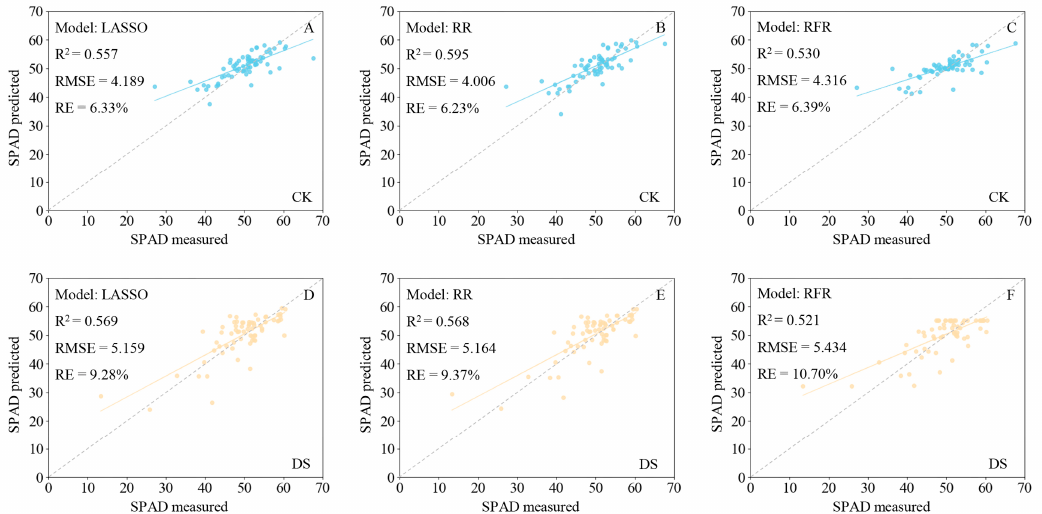
Figure 7. Fitting results of predicted and measured SPAD values of wheat leaves based on a full- band hyperspectral reflectance model under different soil moisture conditions. ( A – C ) Least absolute shrinkage and selection operator (LASSO) regression, ridge regression (RR), and random forest regression (RFR) models under the control condition; ( D – F ) LASSO regression, RR, and RFR models under the drought stress condition. The blue and yellow solid lines are the actual fit between predicted and measured values, and the gray dotted line is the 1:1 fit between the predicted and measured SPAD values. CK, control; DS, drought stress.